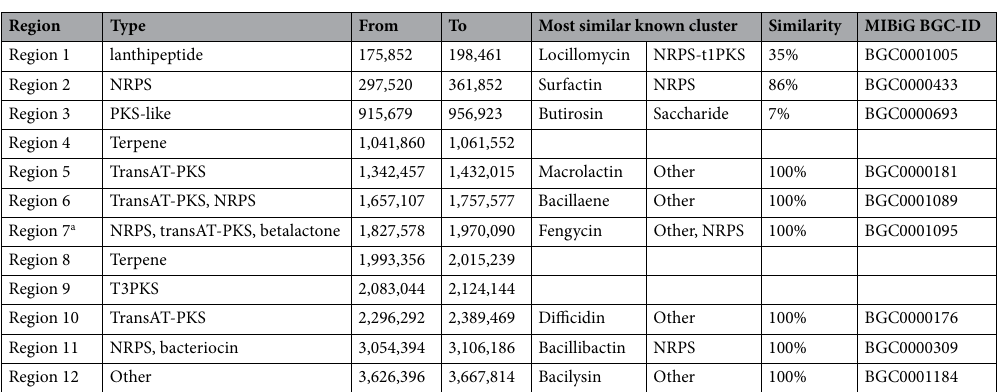
Table 1. ADS024 anti-SMASH results. a Region 7 also identified plipastatin, bacillomycin D, mycosubtilin, iturin and paenilarvin. BGC-ID Biosynthetic gene cluster ID, MIBIG Minimum information about a biosynthetic gene, NPRS non-ribosomal peptide synthetase, PKS polyketide synthase, t1PKS type 1 polyketide